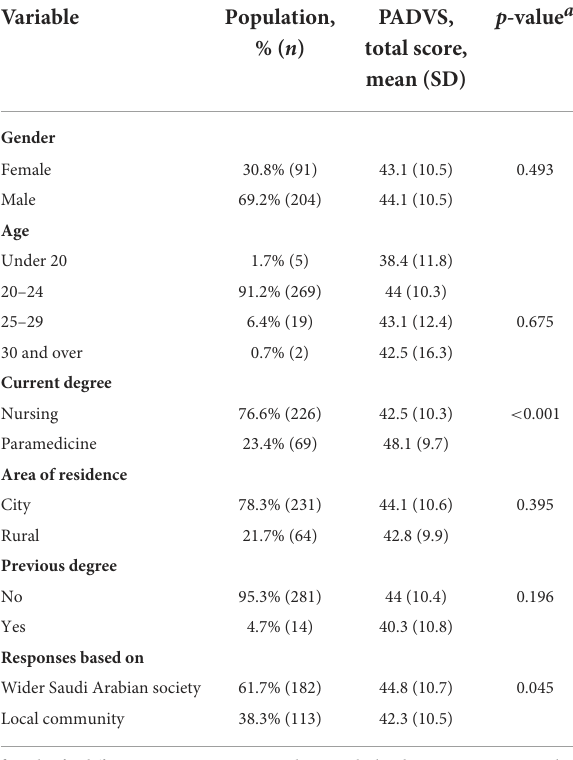
TABLE 1 Demographic characteristics of participants according to perceptions of aging and disaster vulnerability